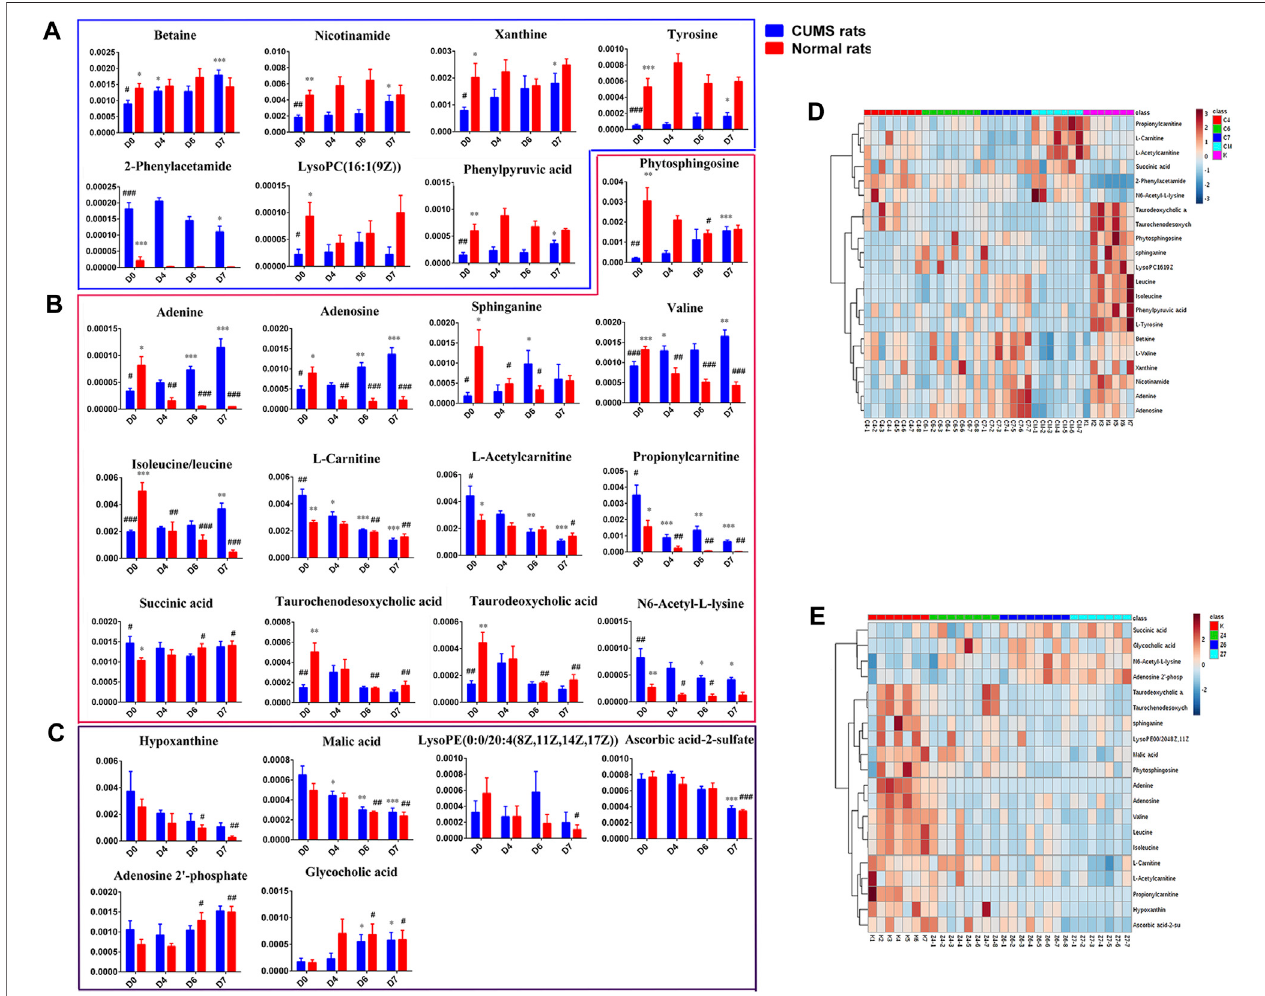
FIGURE5|(A) :DifferentialmetabolitesonlyinliversamplesofCUMSratswithPBRtreatment. (B) :CommondifferentialmetabolitesinliversamplesofbothCUMS and normal rats with PBR administration. (C) Differential metabolites only in liver samples ofnormal rats with PBR administration. (D) : Relative content of the heatmap of differential metabolites in liver samples of CUMS rats with PBR treatment. (E) : Relative content of the heatmap of differential metabolites in liver samples of normal rats with PBR administration. (Normalized intensity levels of differential metabolites in liver samples of CUMS rats ( ■ blue), and the relative content of the corresponding metabolites innormal rats ( ■ red)). D0:administration ofanequal volume ofvehicle.D4-D7: theconcentrationofPBRwas12.5, 5, and 10 g/kg, respectively. (Expressed as the volume of raw materials). Data are presented as mean ± SEM. n (cid:1) 8 each group. * p < 0.05, ** p < 0.01, *** p < 0.001 vs [CM] group; # p < 0.05, ## p < 0.01, ### p < 0.001vs.[K]group;[CM]CUMSrats;[K]controlrats;[C4],[C6],and[C7]CUMSratsgivenPBR(12.6,50,100 g/kg);[Z1],[Z6]and[Z7]controlratsadministered PBR (12.6, 50, 100 g/kg). The ribbon − 4 ∼ 4: represents the relative content of the differential metabolites from low to